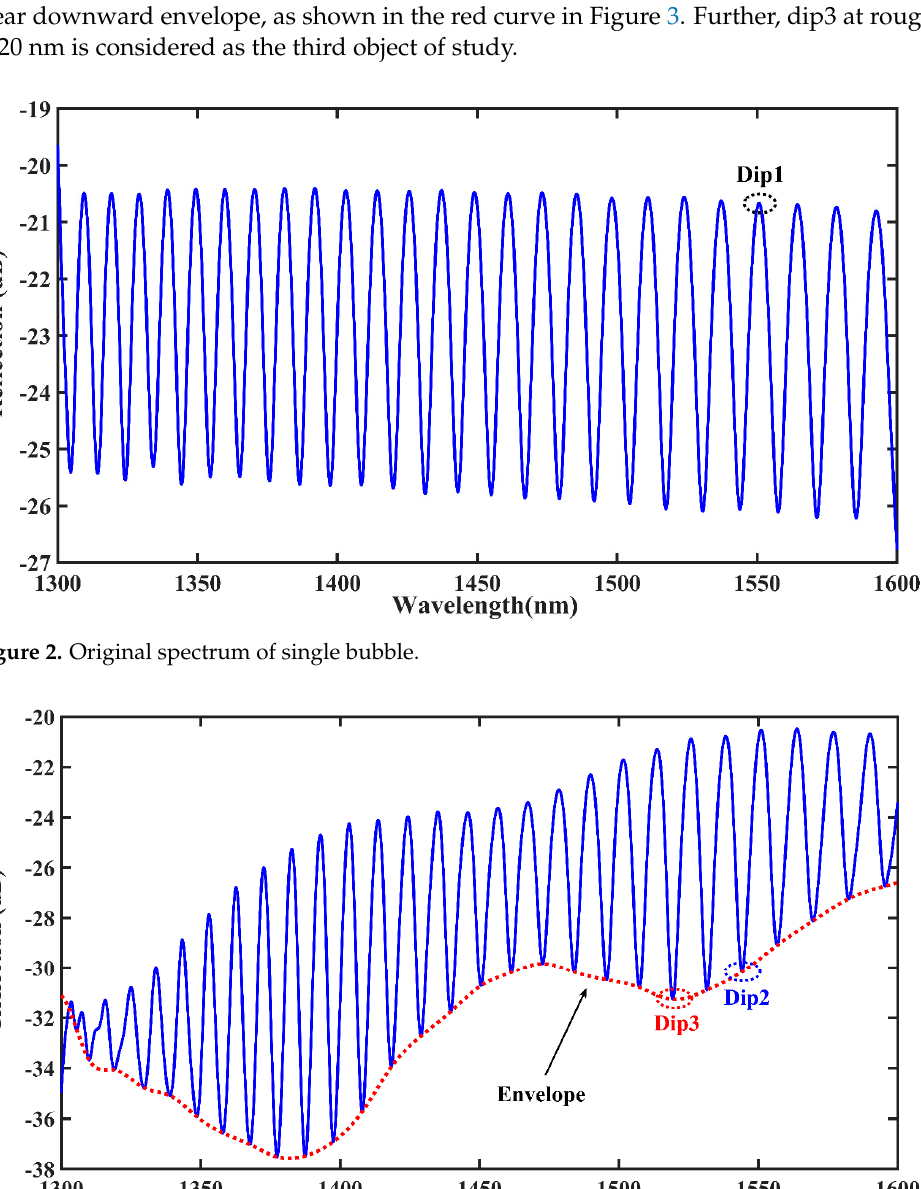
Figure 4. Schematic of strain experimental setup.